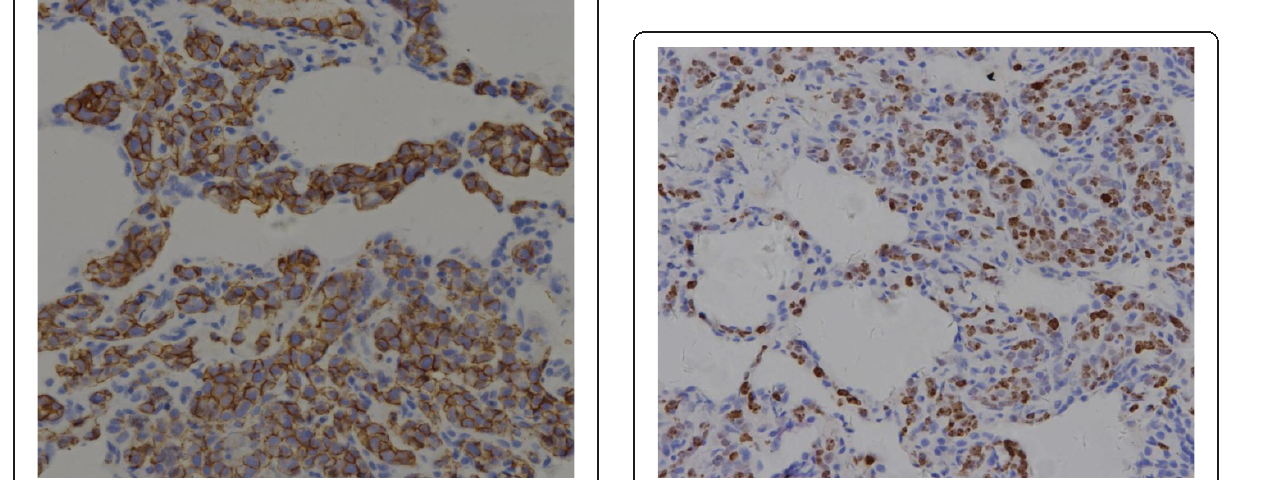
Figure 4 CD20 immunostain of the neoplastic intravascular B lymphocytes (400X).